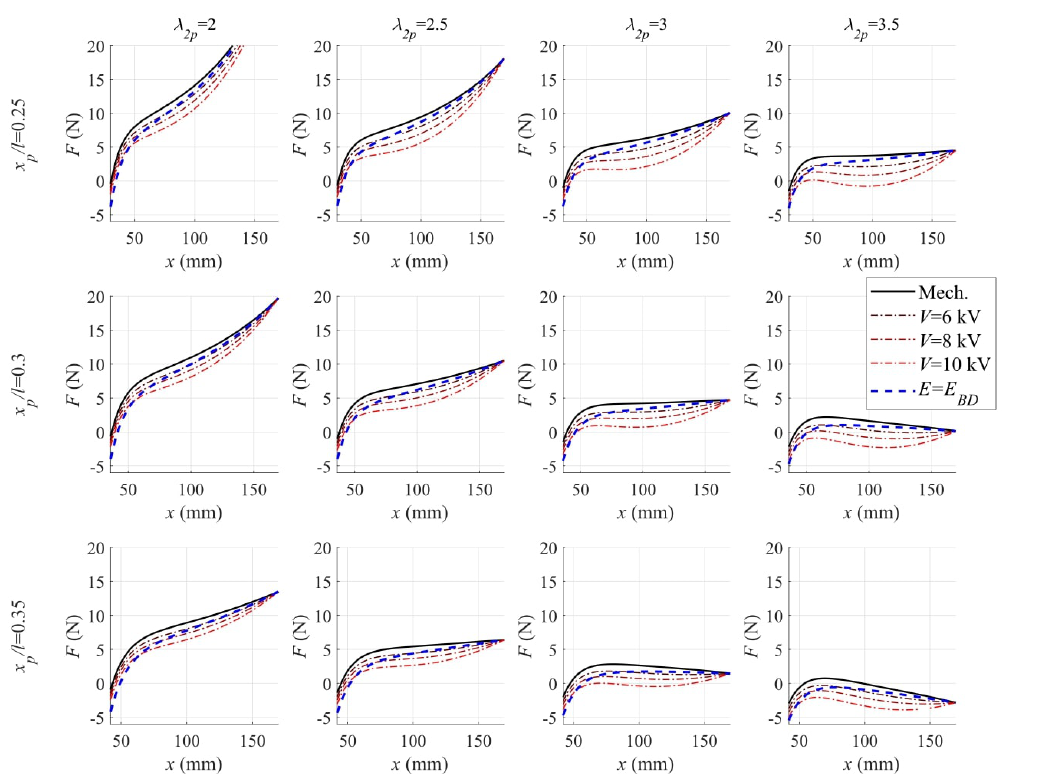
Figure 2. Analytically calculated force-displacement characteristic of the LS-DEA made of SR at different pre-stretches. Solid lines represent the purely elastic contribution; dashed-dotted lines represent the response in the presence of different applied voltages; and dashed lines represent the force at